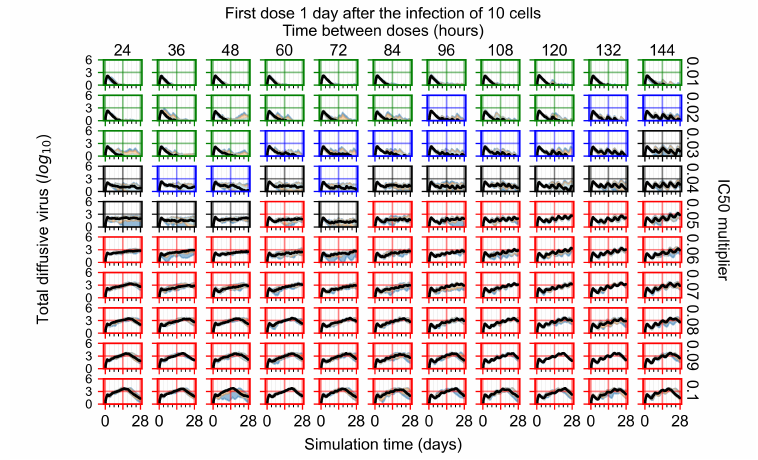
Figure A95. Extracellular diffusive virus quantities (arbitrary units), Y axis in log scale, and exponent values as tick marks.